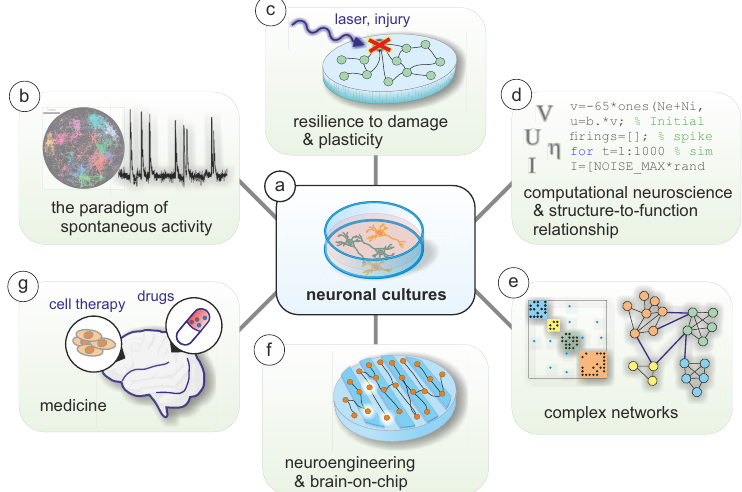
Figure 1. Overview of research projects in Jordi Soriano’s laboratory. ( a ) Neuronal cultures, prepared from either human induced pluripotent stem cells or rodent primary cultures, constitute the central experimental tool. Activity in these cultures is typically recorded using calcium fluorescence